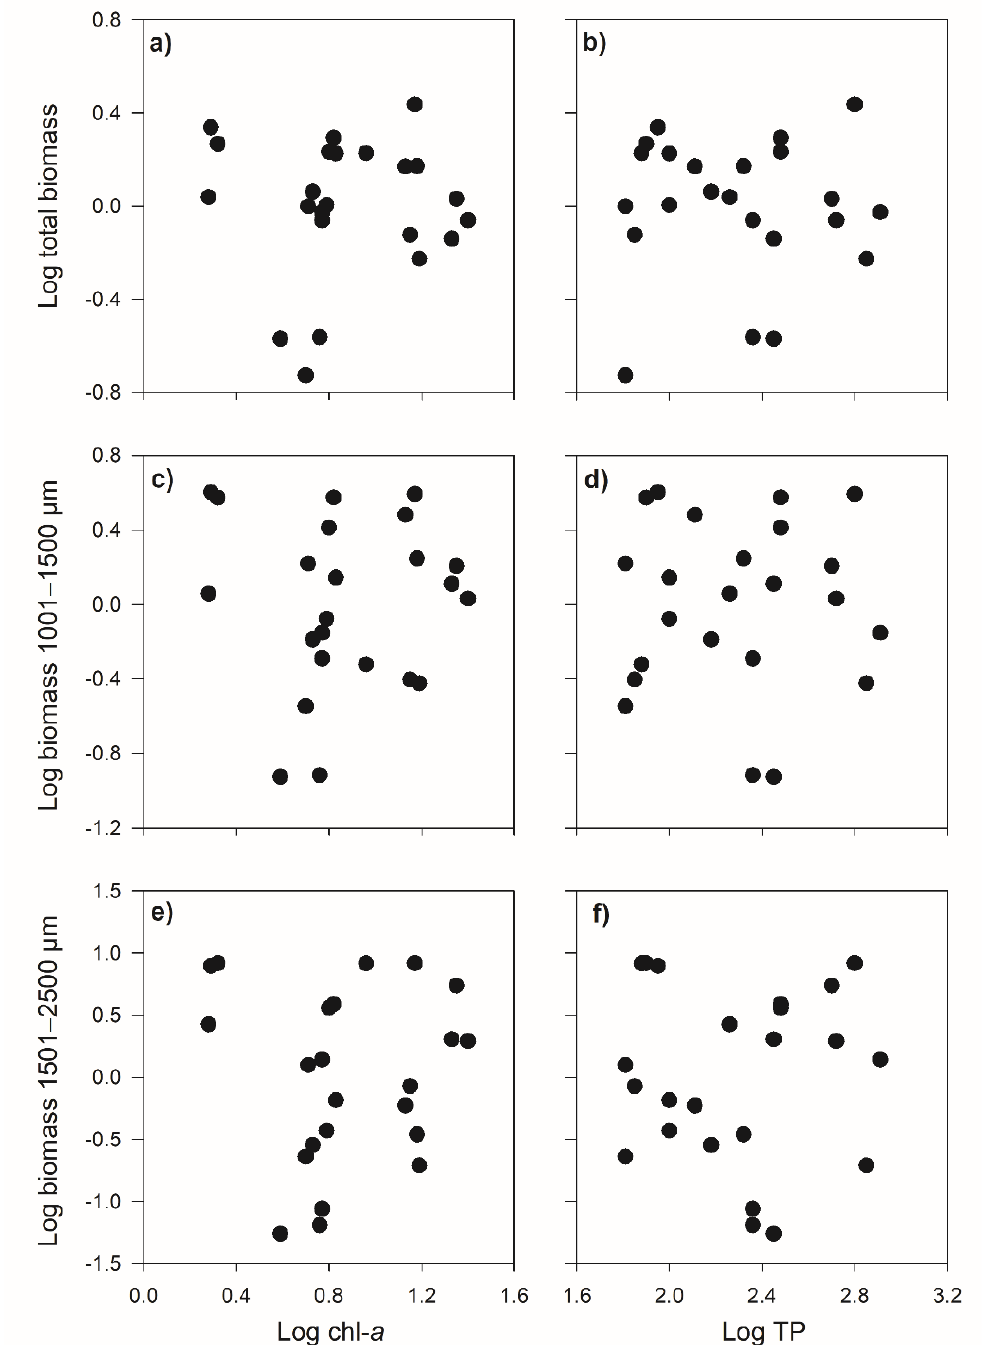
Figure 8. Multiple linear regression, displayed as scatter plots, between environmental variables chlorophyll- a (chl- a ) and total phosphorus (TP) and the biomass of different size groups. Between chl- a and TP and: ( a , b ) total biomass; ( c , d ) biomass size fraction 1001–1500 µ m; and ( e , f ) biomass size fraction 1501–2500 µ